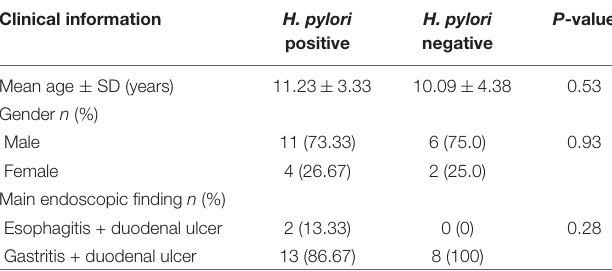
TABLE 1 | Summary of the study subjects’ characteristics. Clinical